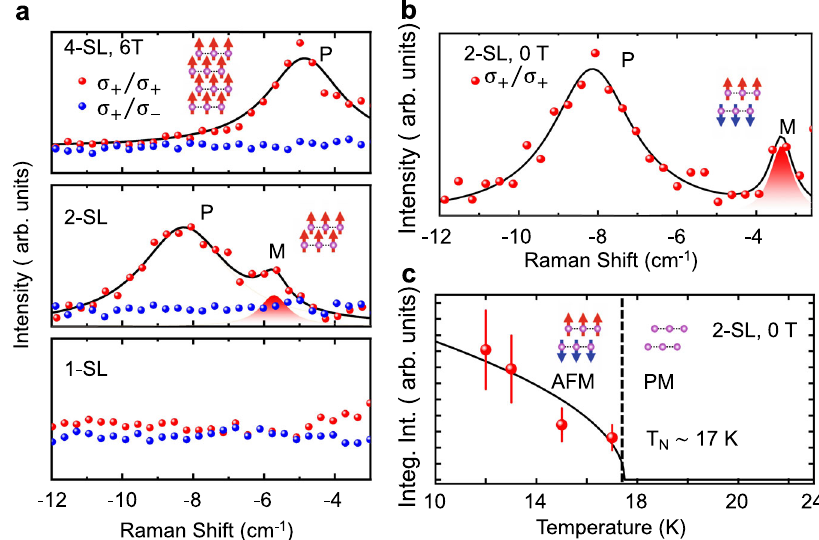
Fig. 2 Raman spectra of magnon in different setuple layers, magnetic fi elds, and its temperature dependence at zero fi eld. a Raman spectra taken at 12 K and 6 T fi eld in 1-SL (bottom), 2-SL (middle), and 4-SL (top) MBT taken with co-circular σ + / σ + (red points) and cross-circular σ + / σ − (blue points) polarized incident and scattered photons. Black solid line is fi tting with the sum of two Lorentzian functions, corresponding to a phonon (P) and a magnon (M) mode, respectively. b Raman spectrum from the 2-SL taken with co-circular polarizations at 12 K and 0 T. c Temperature dependence of the integrated Raman intensity of the ~3.4 cm − 1 magnon peak from the 2-SL at 0 T. The intensity diminishes as the 2-SL goes through the antiferromagnetic (AFM) to paramagnetic (PM)